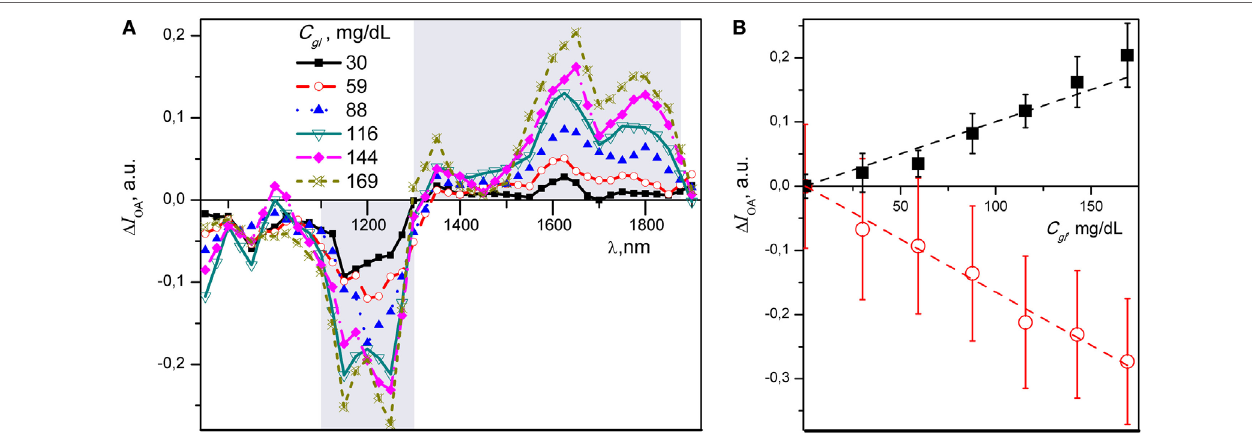
FIGURe 3 | (A) Differential near-infrared (NIR) optoacoustic spectra of various glucose concentrations in aqueous media. Note negative and positive changes of the NIR optoacoustic spectral absorption. Each data point is a mean of five independent measurements. (B) Summary graph of the intensity—concentration relationship for Δ I OA of glucose estimated at 1,250 nm (red) and 1,650 nm (black) wavelength with linear fits. Mean of five individual measurements are presented with